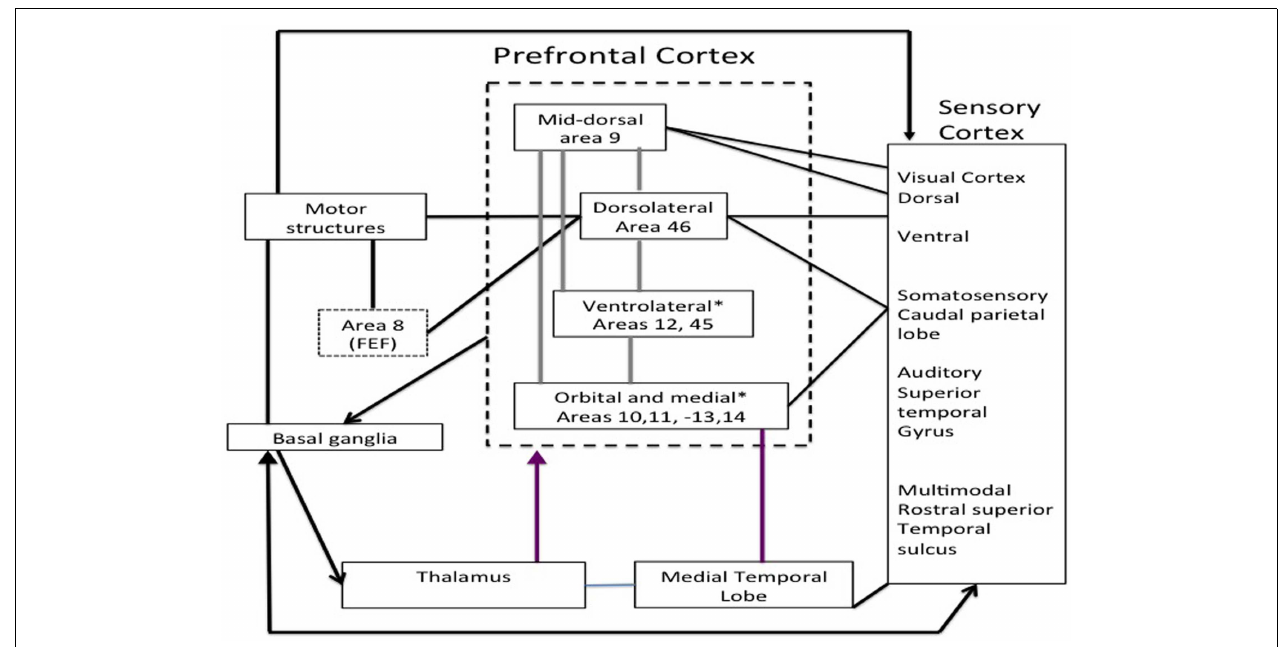
FIGURE 1 | Main regions of the prefrontal cortex adapted Miller and Cohen (2001)